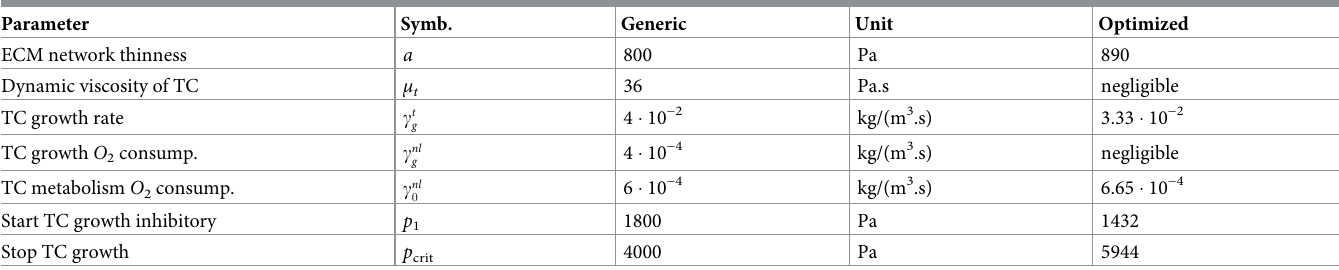
Table 1. Parameters for the CT26 cell line. Source of the generic values: [17, 20, 23, 29]. Parameter